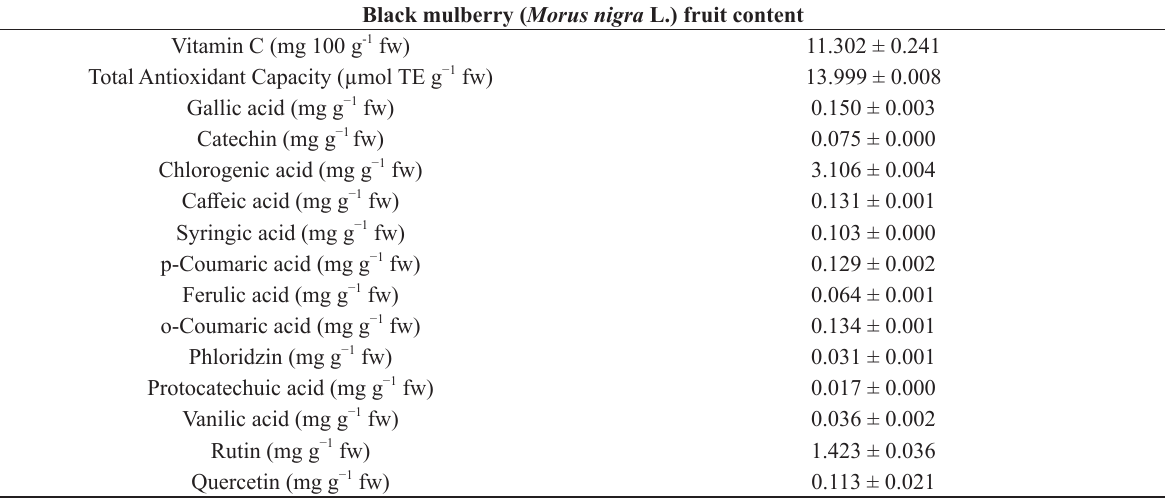
Phenolic compound content, vitamin C (ascorbic acid) content and total antioxidant capacity of black mulberry fruit (from Gundogdu et al.